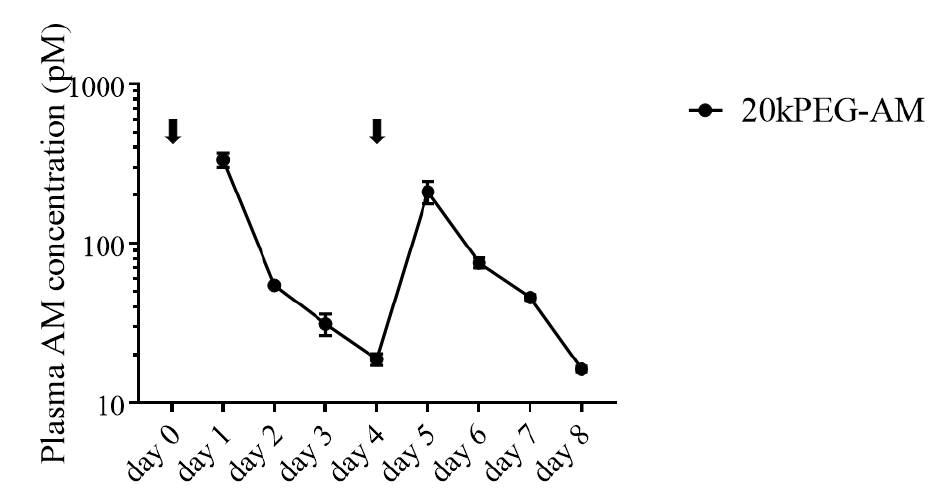
Figure 3. Plasma clearance of 20kPEG-AM. 20kPEG-AM (10 nmol/kg) was administered by subcutaneous injection on days 0 and 4. Blood samples were collected at the indicated time points. Data are presented as means ± S.E.M. Three mice were examined at each time point.